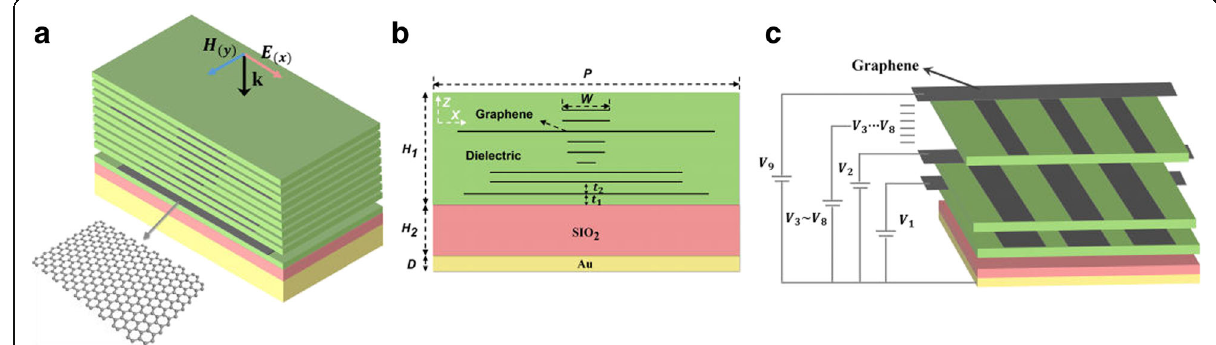
Fig. 1 a Schematic diagram of the graphene-based broadband absorber. b Cross section of the absorber with the parameters used for calculation. c The schematic of the external bias circuit. The branches of the voltage ( V 1 ~ V 9 ) are connected to diferent graphene layers,